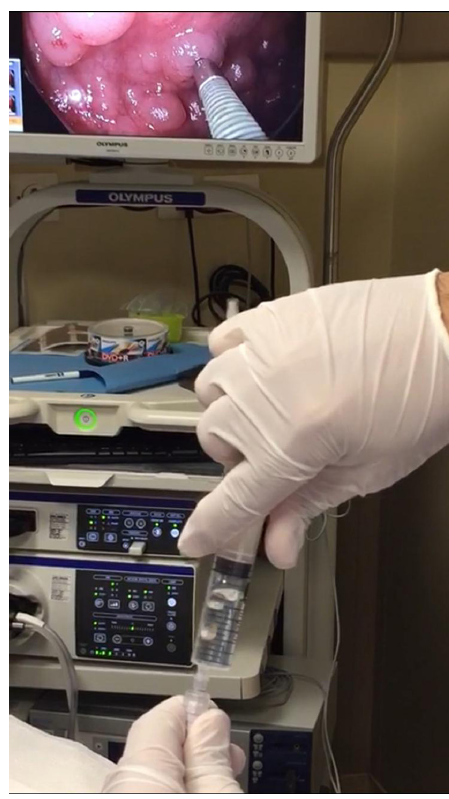
Figure 2. During the colonoscopy, aspiration of the polypoid lesions by using a sclerotherapy needle.